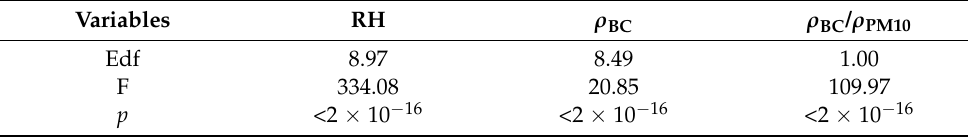
Table 5. GAM simulation results of aerosol scattering hygroscopic growth